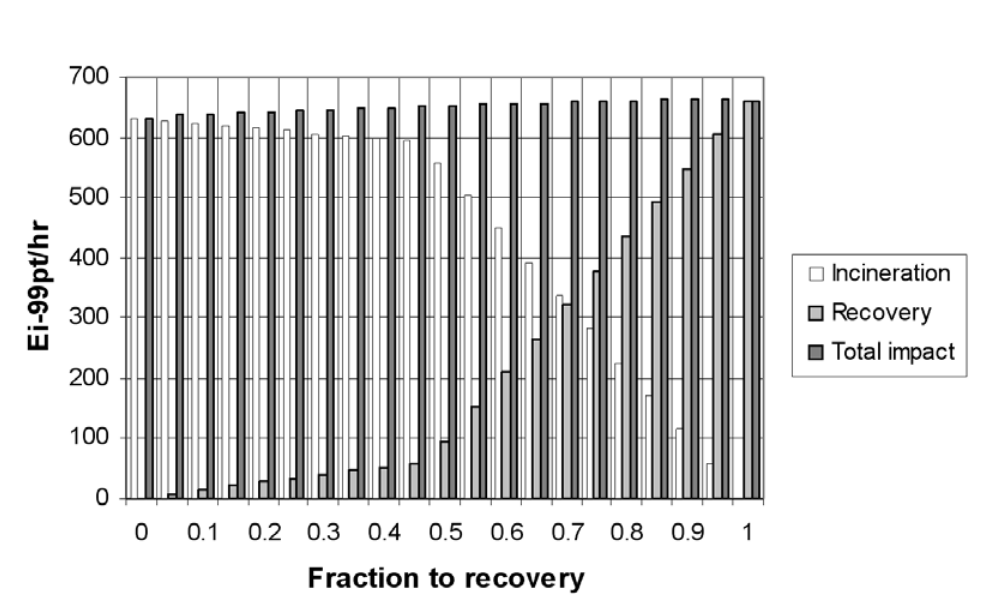
Fig. 5 Environmental impacts of the simultaneously working recovery applying ternary cut scheme and